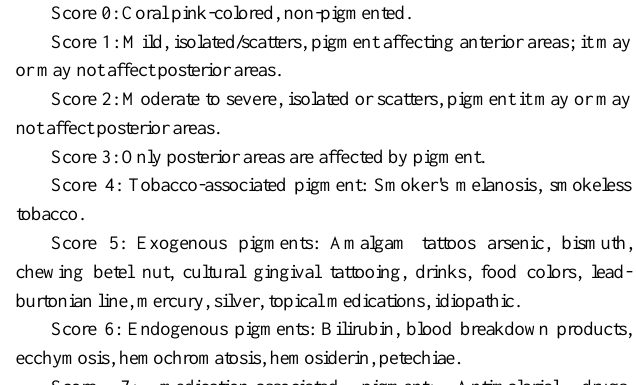
Fig. 2. Upper arch depigmentation.